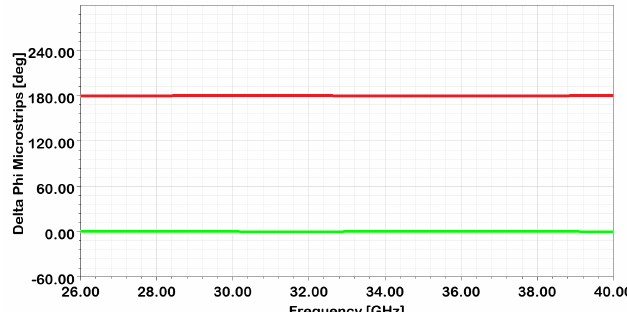
FIGURE 9 . Phase difference of the central (red) and lower (green) port with respect to the upper microstrip port.